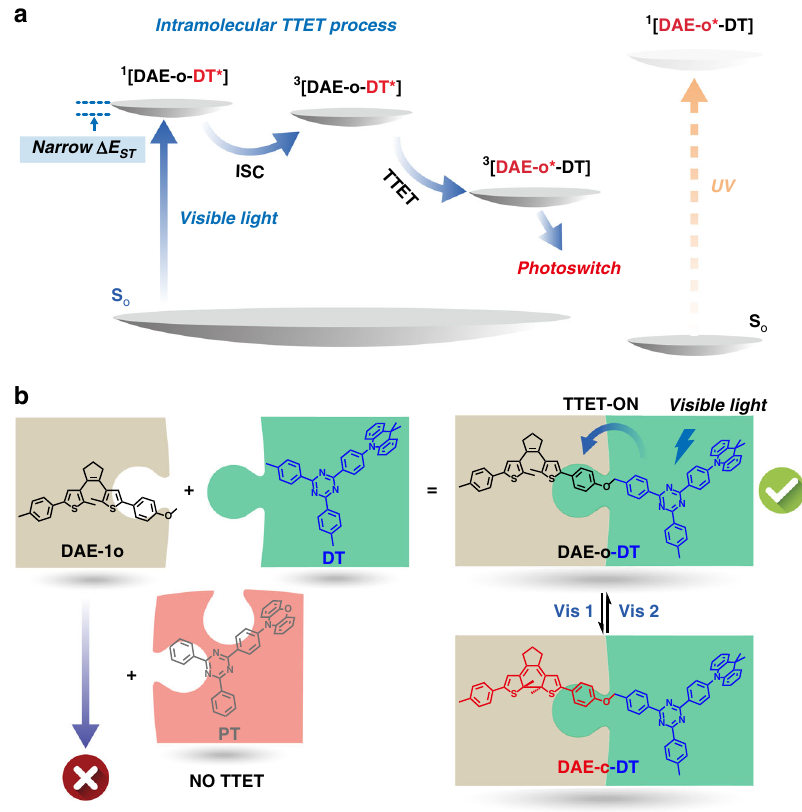
Fig. 1 Molecular design of the visible-light photochromic DAE-o-DT and its working mechanism. a Illustration of the working mechanism for the intramolecular TTET-induced visible-light photochromism with narrow Δ E ST sensitizer. b Structures of the investigated building blocks and the photoswitching with visible lights in both